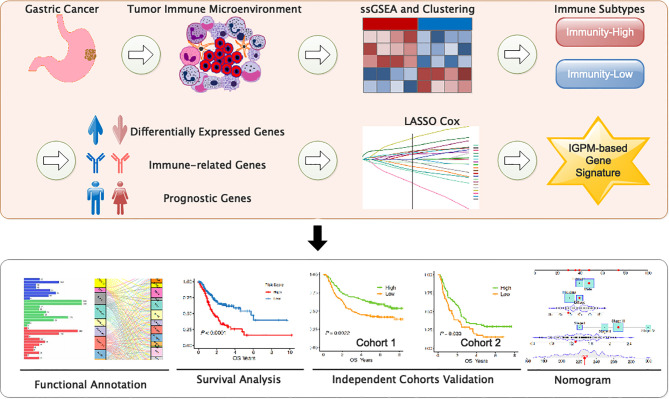
Study flowchart.